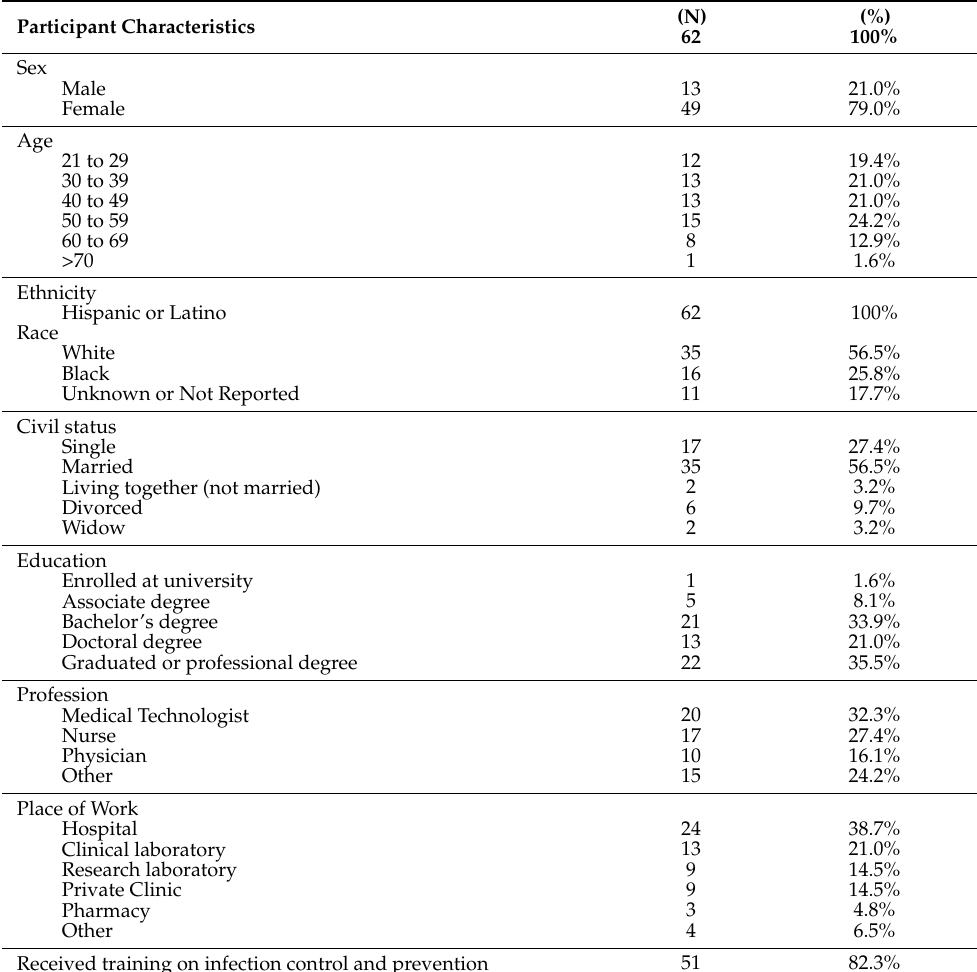
Table 1. Demographic characteristics of healthcare workers (HCWs) during the COVID-19